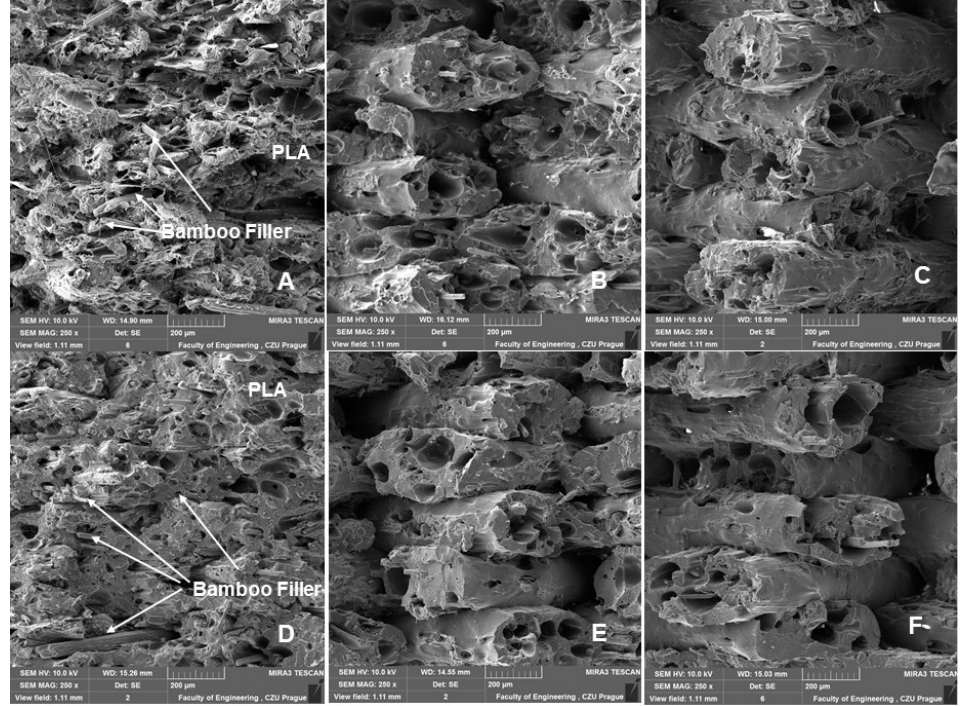
Figure 14. SEM images—fractographic analysis—nozzle 0.6 mm (MAG 2.50 × ): ( A ): Infill density 100%, static tensile test; ( B ): Infill density 80%, static tensile test; ( C ): Infill density 60%, static tensile test; ( D ): Infill density 100%, low cyclic fatigue; ( E ): Infill density 80%, low cyclic fatigue; ( F ): Infill density 60%, low cyclic fatigue.